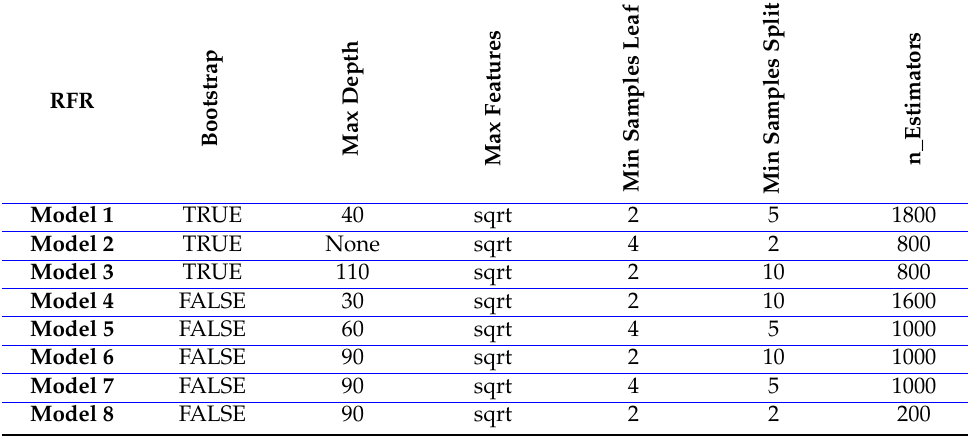
Table A3. Optimal hyperparameters for the RFR models (d-serie laser module).